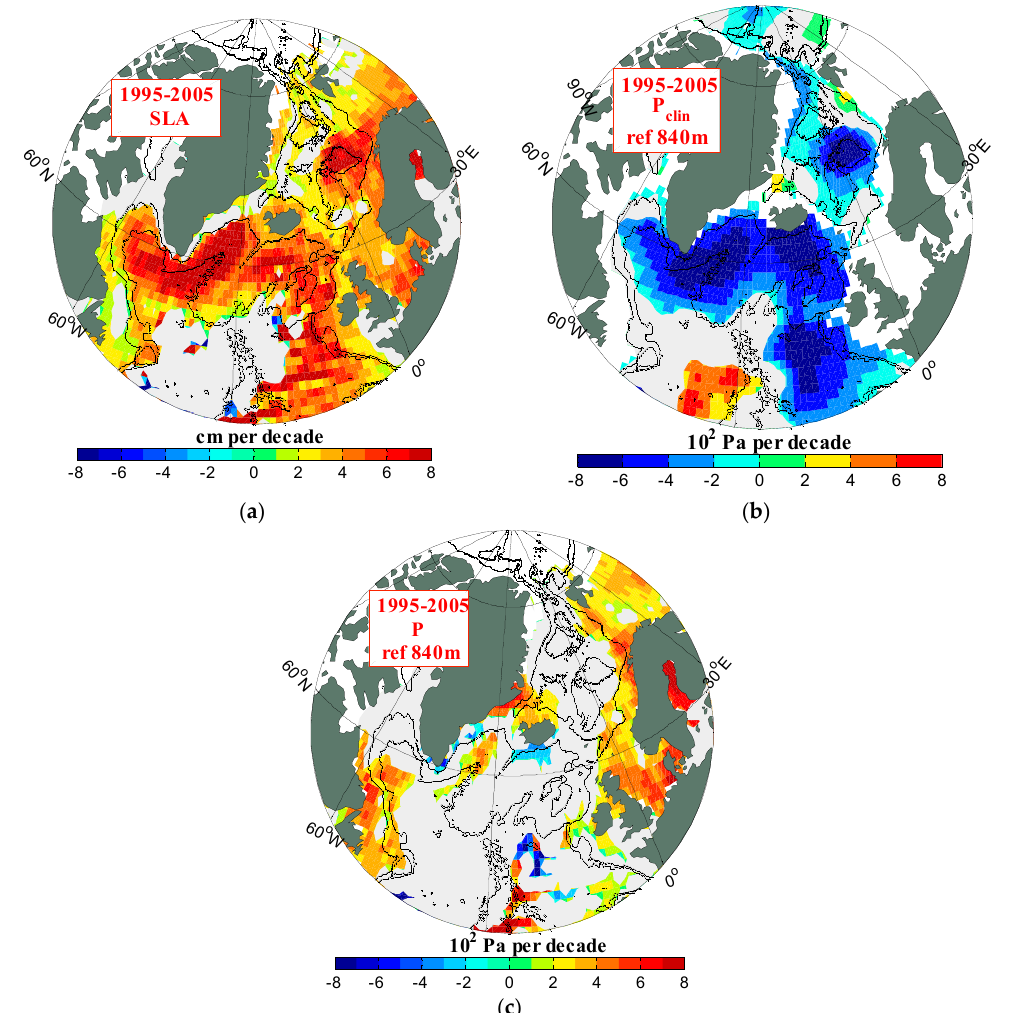
Figure 3. The change trend of SLA ( a ), P clin ( b ), and P ( c ) from 1995 to 2005. The gray area represents the sea area that has not passed the 95% significance test; the white area represents the sea area where the period of missing data is longer than 7 years; the black lines are the 1000 and 3000 m isobaths. The pressure is calculated based on a reference depth of 840 m.